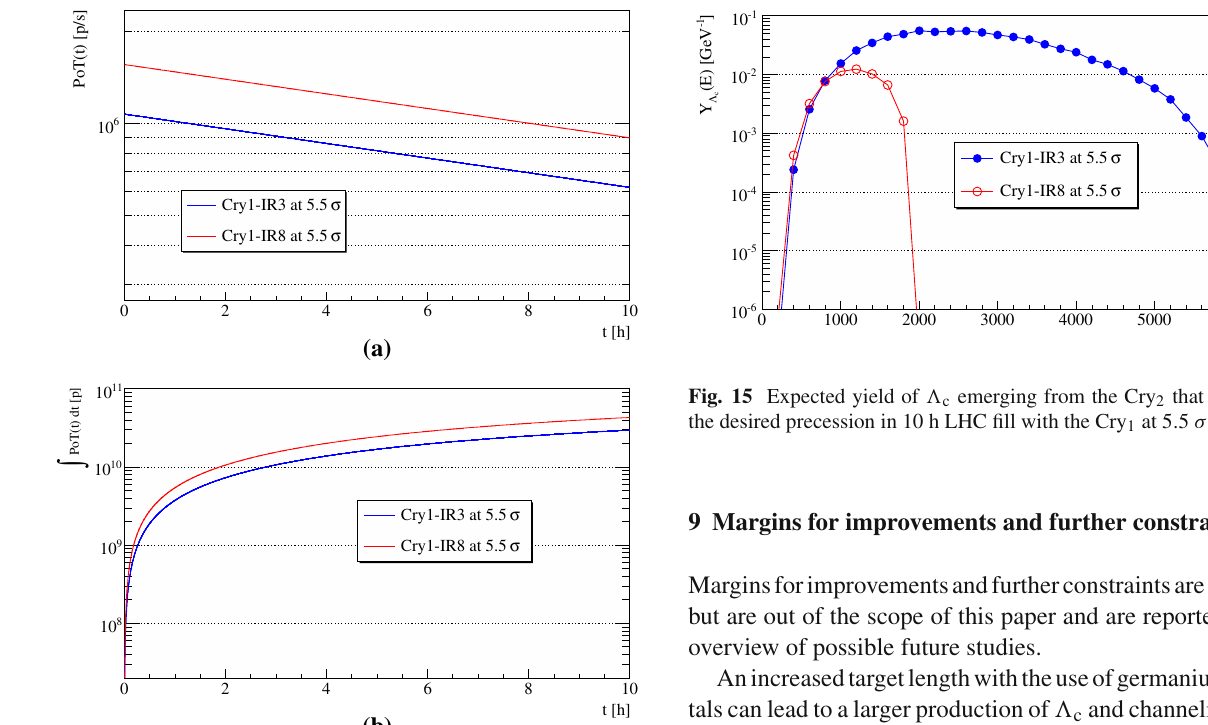
9 Margins for improvements and further constraints